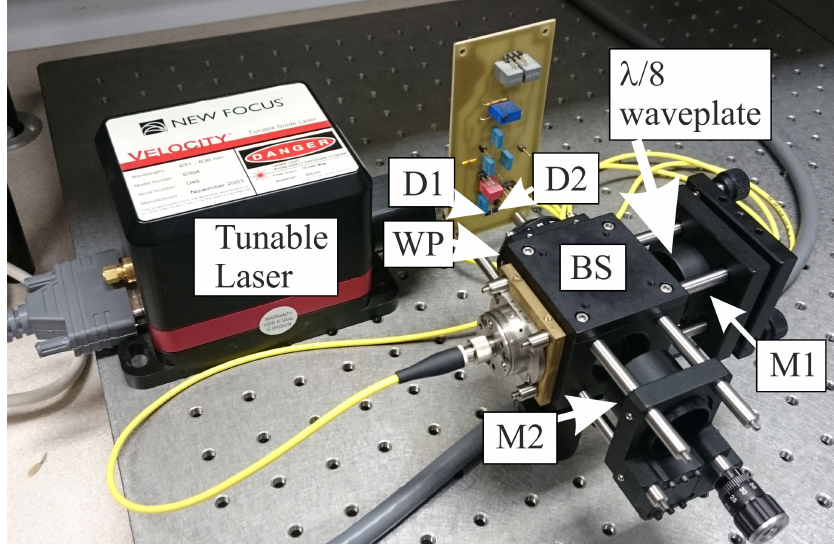
Figure 4. Polarization interferometer during the alignment procedure. M1,